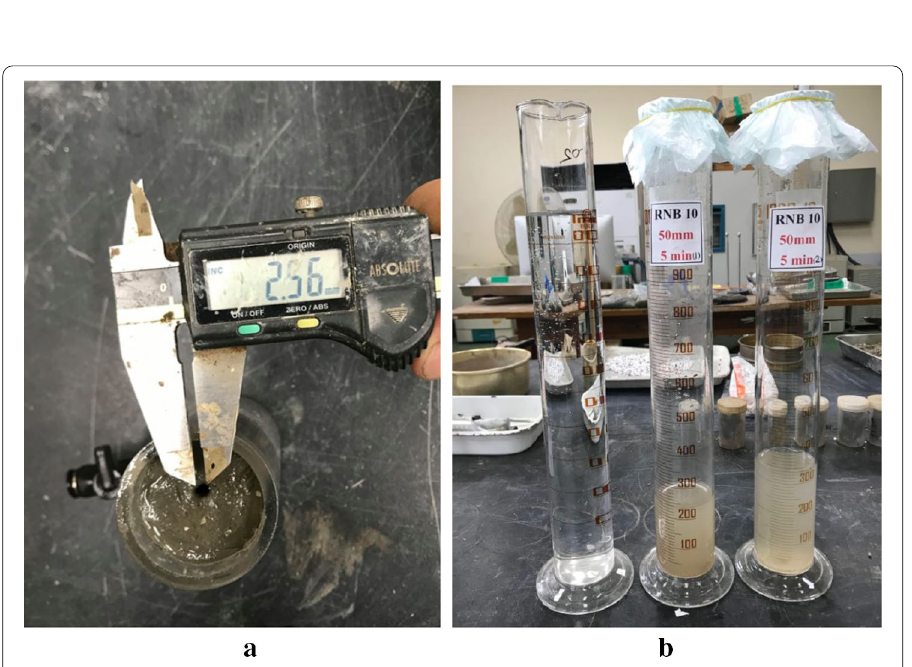
Fig. 14 a Hole size after test and b water collected from